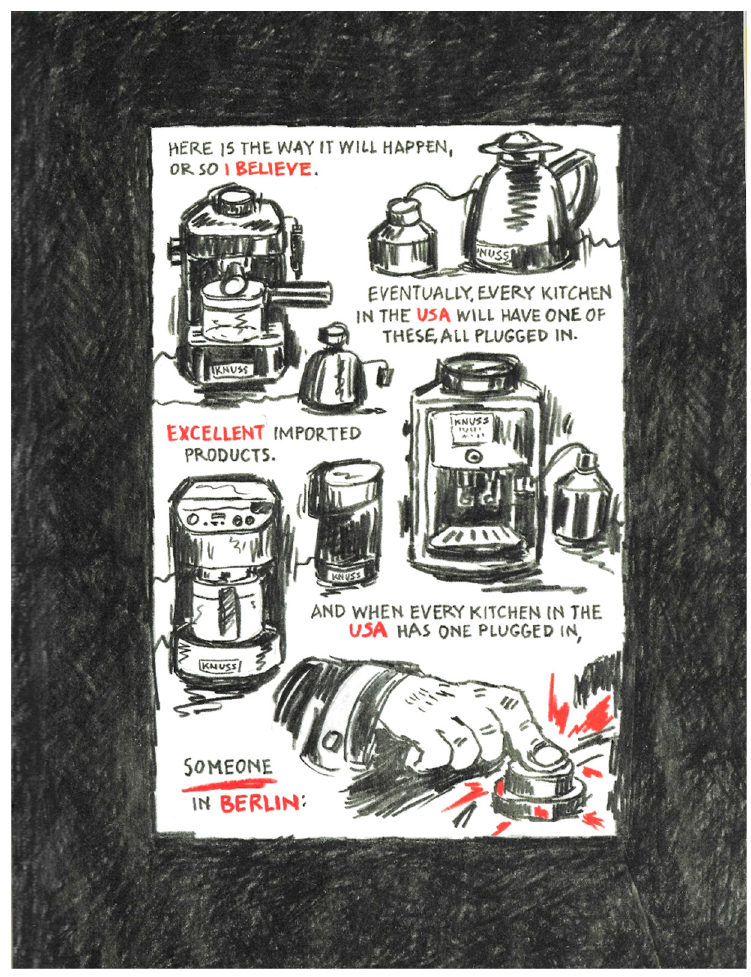
Figure 5. Letting It Go (Katin 2013). Reproduced by permission of Miriam Katin.